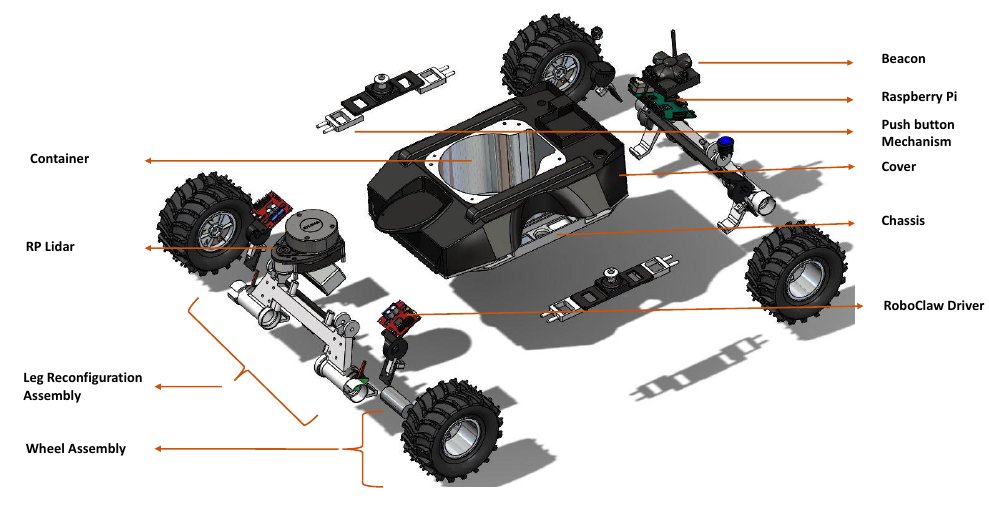
Figure 1. Mechanical